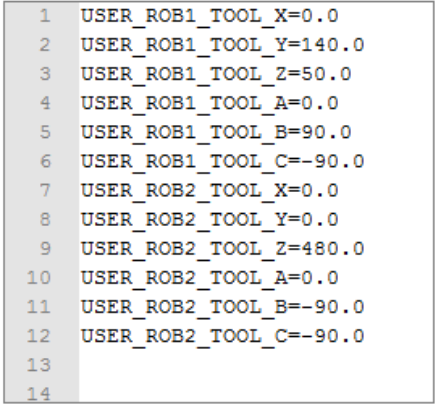
Figure 24: Example of a User Tool text file